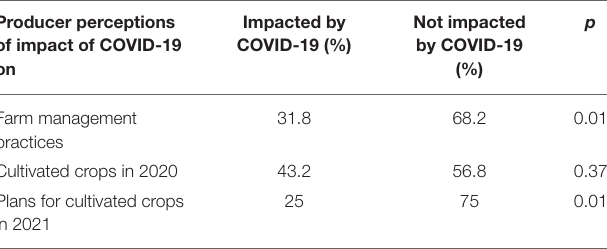
TABLE 4 | Producer perceptions on COVID-19 pandemic impacts on